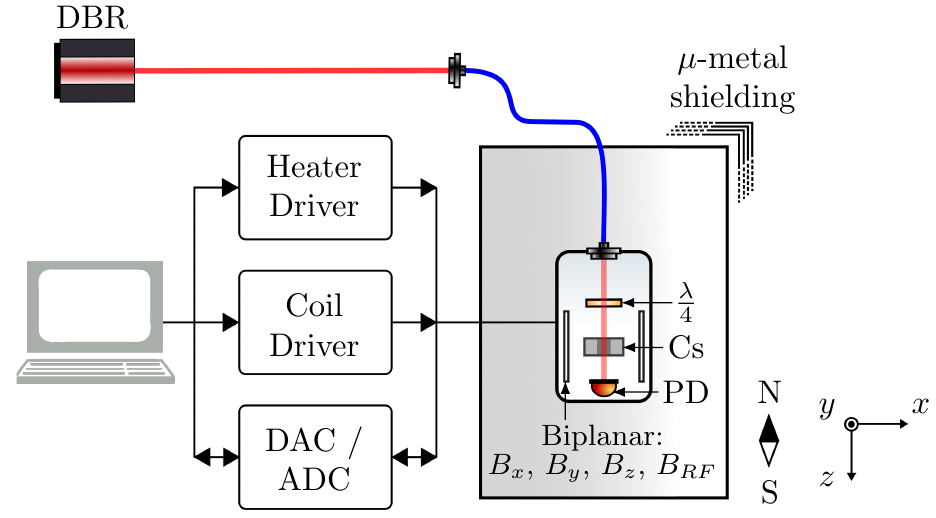
Figure 1. Experimental setup. Elliptically polarised light from a distributed Bragg reflector (DBR) F (cid:48) = 3 hyperfine transition of the Cs D 1 line is fibre-coupled to pass laser close to the F = 4 → through a micro-fabricated atomic vapour cell [25,26] filled with a saturated vapour of Cs and 211 Torr of nitrogen buffer gas. The cell is heated through resistive heating by square-wave modulated current provided by a custom high efficiency heater driver. Three pairs of biplanar coils, B x , B y , B z , control the static magnetic field along each axis, and an additional modulation coil, B RF , allows the application of an oscillating field along the y -axis. The static field coils are driven using a custom low-noise current driver [27]. The photodetector (PD) measures light transmitted through the vapour cell. A low nT-level magnetic field environment is provided by a 5-layer µ -metal shield. λ /4, quarter waveplate; Cs, caesium vapour cell; ADC, analog-to-digital converter; DAC, digital-to-analog